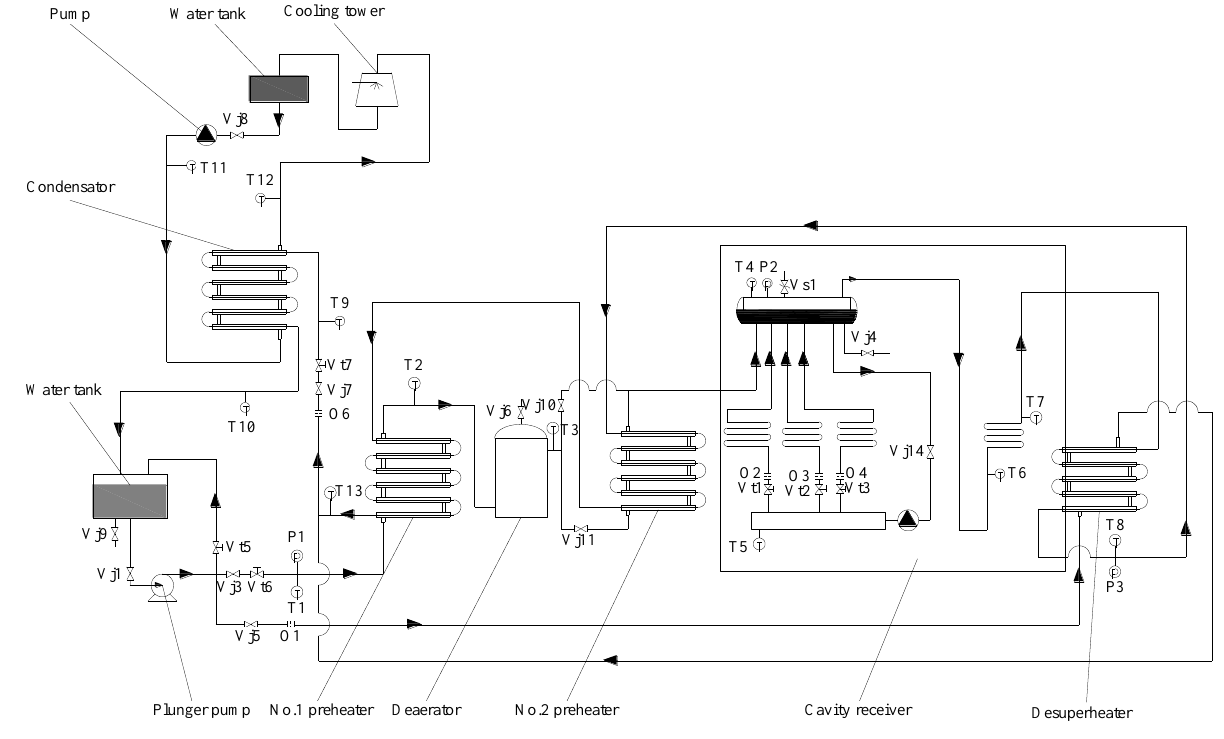
Figure 1. System diagram of the experiment